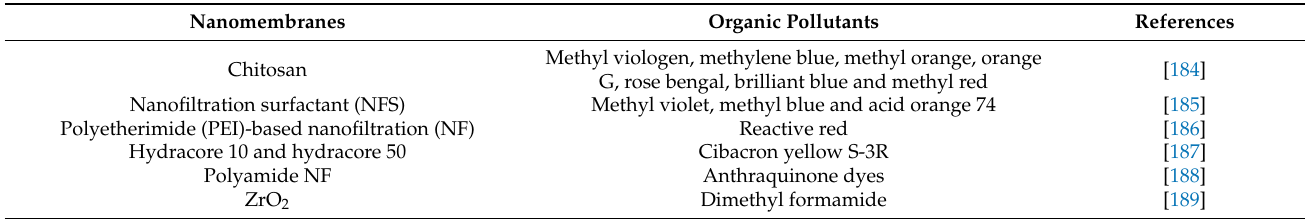
Table 8. Azo dye degradation with